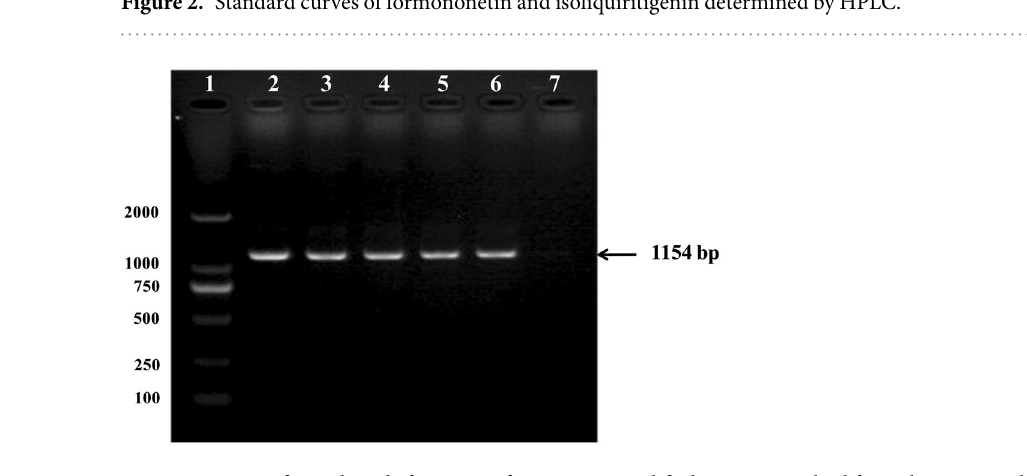
Figure 3. A specific nucleotide fragment of PCV2 was amplified via PCR method from the mouse spleen tissue. 1: DL2000 DNA marker; 2–5: spleen samples collected from PCV2 group; 6: positive control (virus dilution); 7: spleen sample from control mice without PCV2